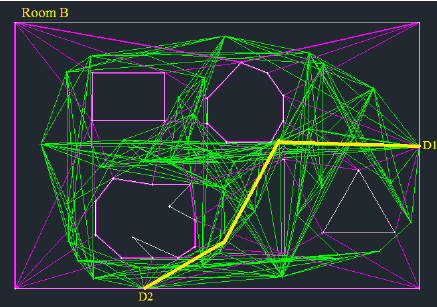
Figure 10. Resulting network for navigation (green) and the shortest path (bold